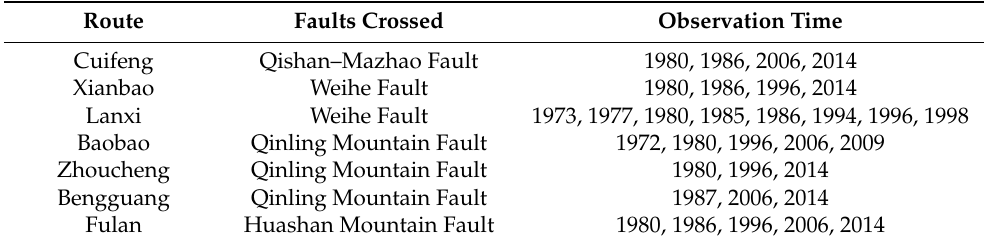
Table 2. Observation times of the leveling routes.